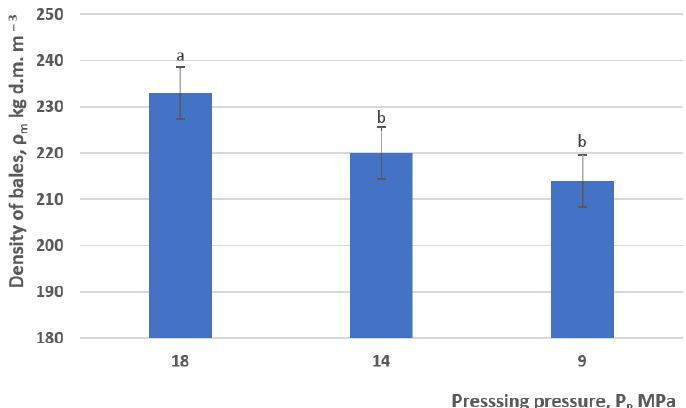
Figure 9. Bar chart of balage density in bales at different pressing pressures (Pp) for plant material at 56% moisture content and a length Lm of 183 mm. Different lowercase letters indicate a statistically significant difference at p ≤ 0.05. d.m., dry matter.